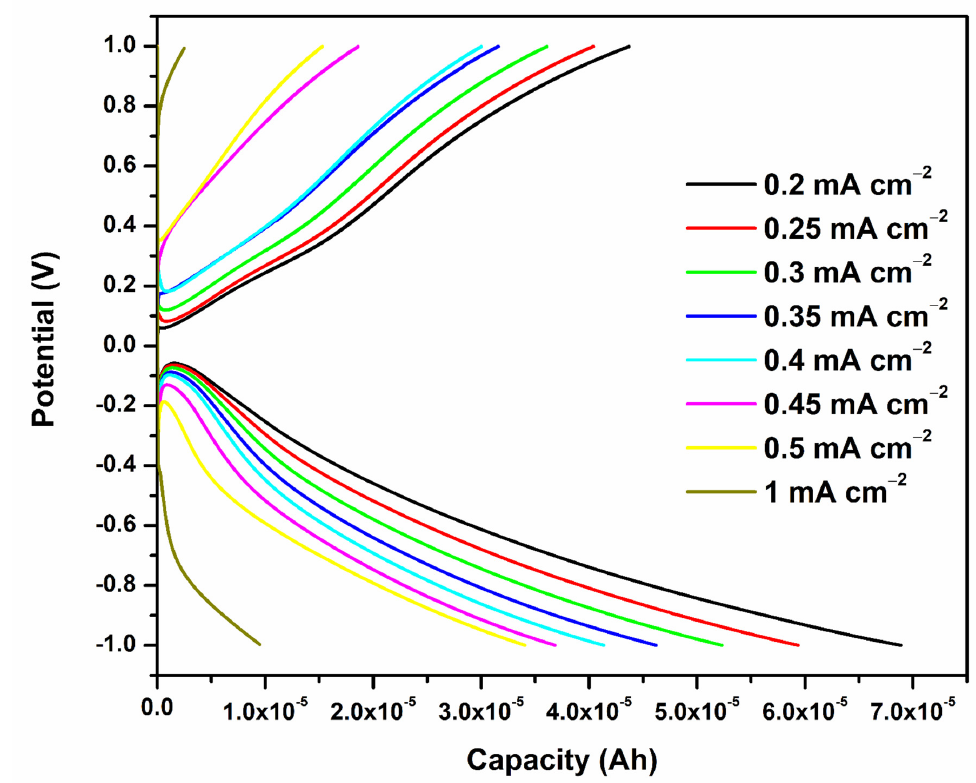
Figure 8. Charge–discharge curves of prototype battery with PVA − 20 wt% TEOS (PE − 1) at different current densities (0.2 to 1 mA cm − 2 ). Table 1. Fitted impedance values of plane PVA (PE), PVA-20 wt% TEOS (PE-1), PVA-40 wt%